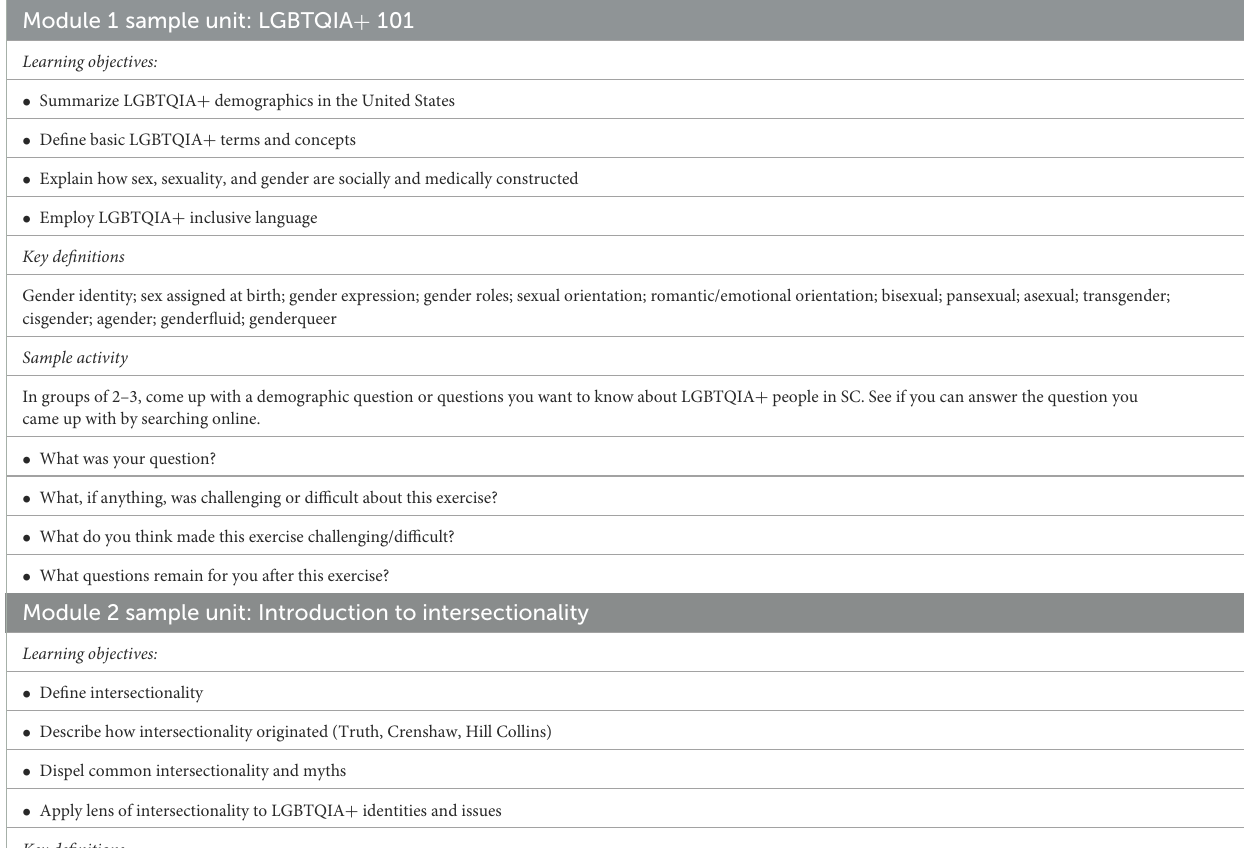
TABLE 1 Sample unit with learning objectives, definitions, and